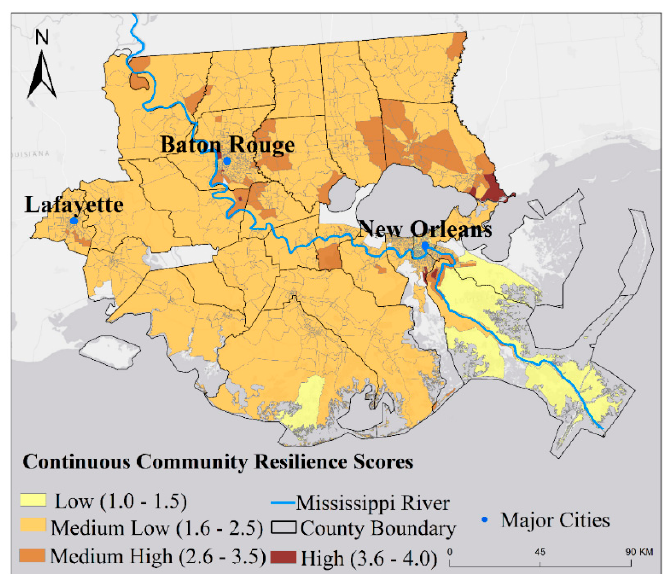
Figure 6. Continuous RIM scores map by block-group; scores ranging from 1–4, the higher the score, the more resilient [41].